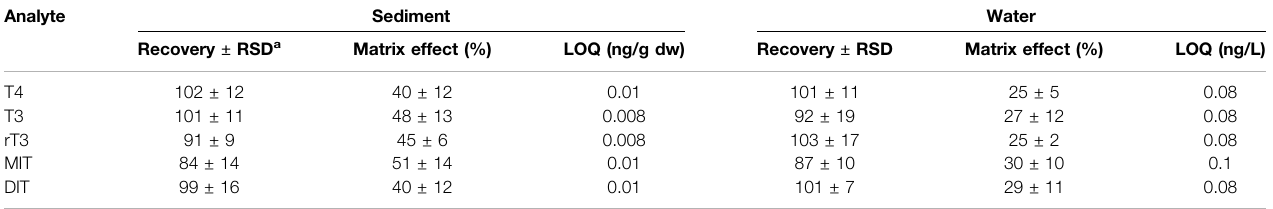
TABLE 2 | Recoveries (%), matrix effects and limits of quantitation (LOQ) of the target thyroid hormones from sediment and water samples ( n (cid:2) 5). Analyte